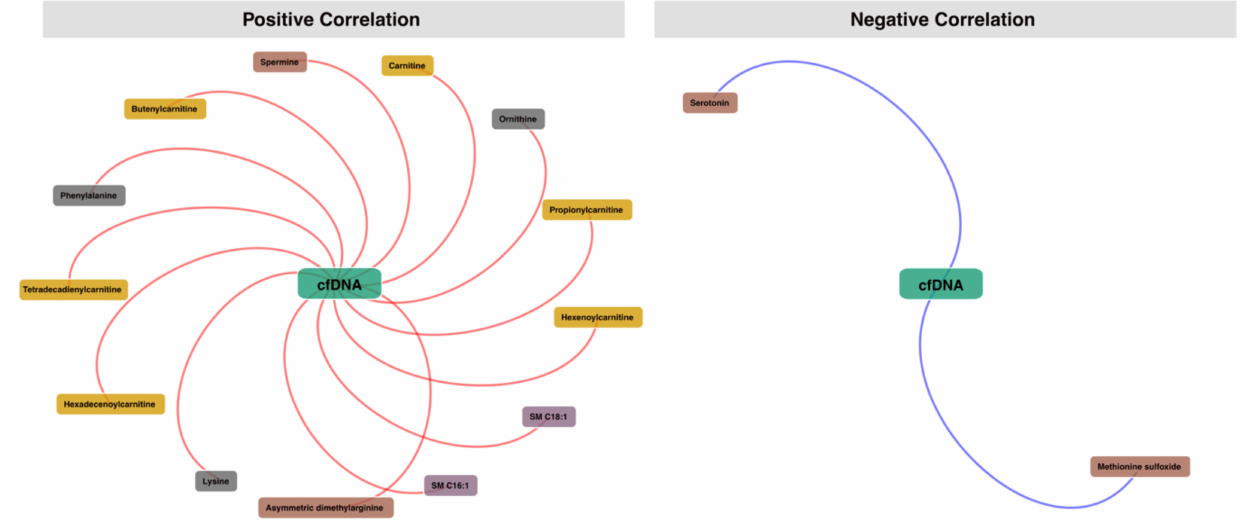
Figure 6. Spearman correlation analysis between metabolic profiles and free circulating DNA. Cut-off was set at adjusted p -value > 0.05 and abs(Spearman rho) > 0.25. Multiple test correction was applied for p -values using Benjamini and Hochberg method is